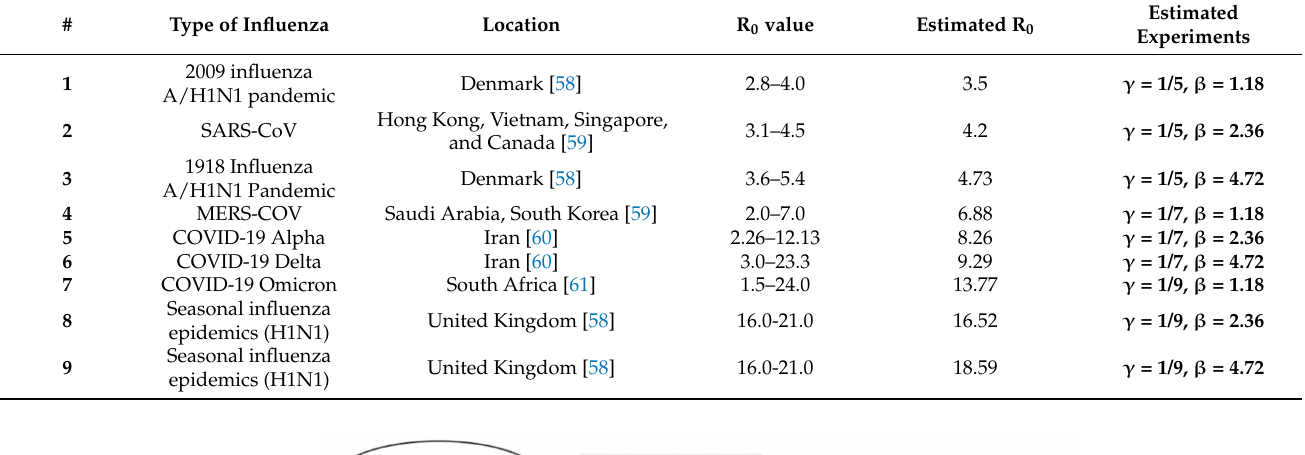
Table A1. Suggested epidemic experiments with their origin sources.